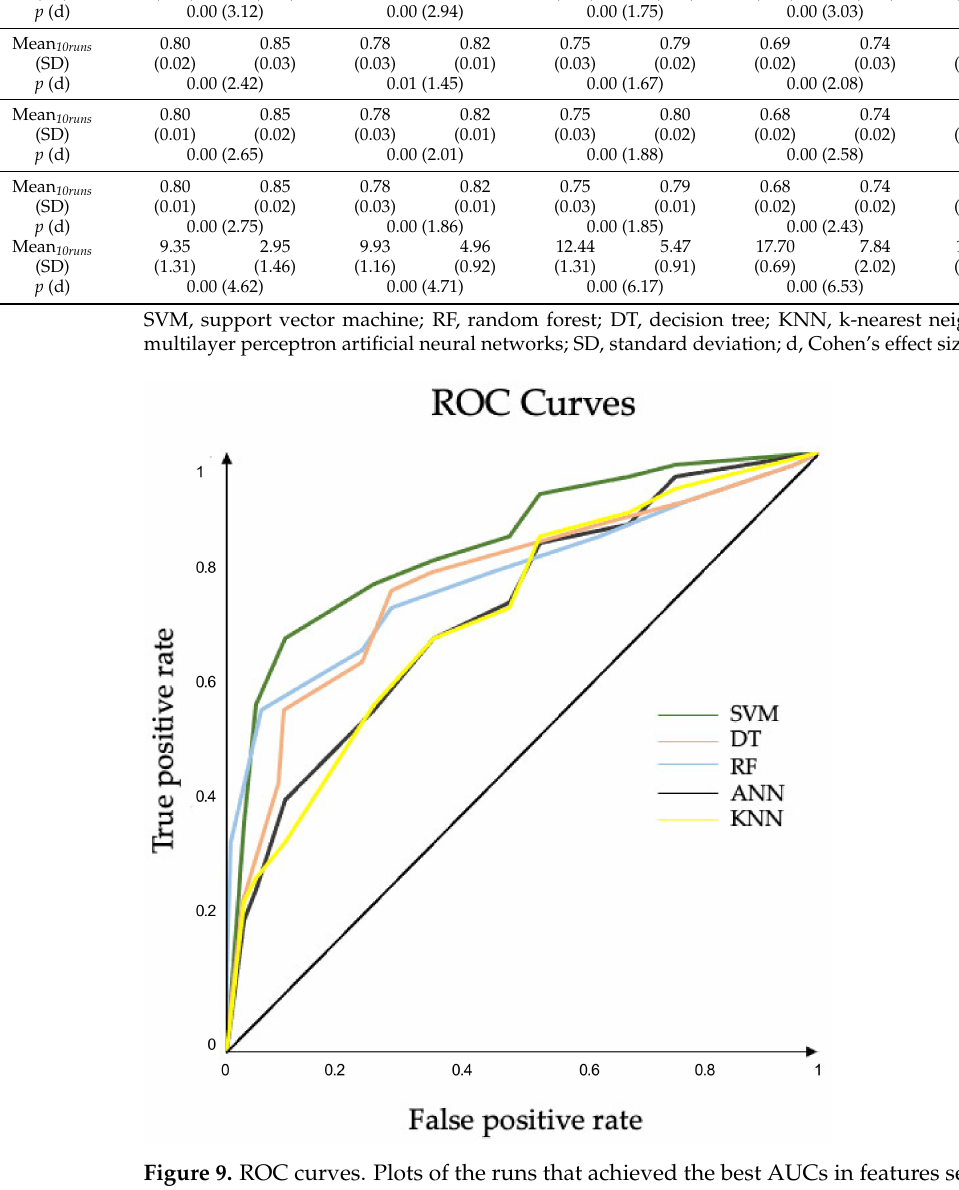
Figure 9. ROC curves. Plots of the runs that achieved the best AUCs in features selected approach for each ML algorithm. AUC SVM (0.877), AUC RF (0.827), AUC DT (0.820), AUC ANN (0.810), AUC KNN (0.778): ROC, receiver operating characteristic; AUC, area under curve; SVM, support vector machine; RF, random forest; DT, decision tree; KNN, K-nearest neighbor; ANN, artificial neural network. ROC curves for the maximum accuracies obtained by each